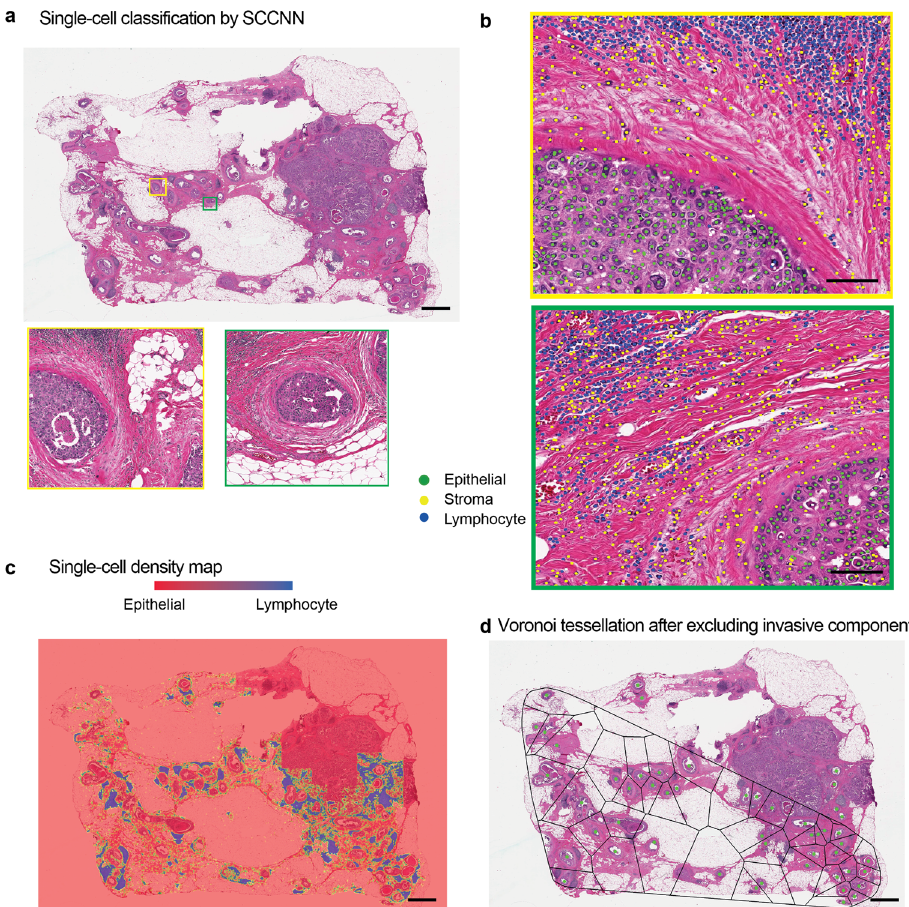
Fig. 5 UNMaSk results with single-cell classi fi cation and Voronoi tessellation. a A representative example of an adjacent DCIS case illustrating single-cell classi fi cation results in two DCIS regions. Scale bar represents 100 µm. b High-resolution images of areas within the two DCIS regions, showing single-cell classi fi cation using uni fi ed segmentation and classi fi cation pipeline based on DRDIN and SCCNN, classifying cells into the epithelial cell (green), stromal cell (yellow) and lymphocyte (blue). Scale bar represents 50 µm. c Heatmap showing lymphocyte cell density based on single-cell classi fi cation results. d Voronoi tessellation using the centres of DCIS ducts as seeds, performed over tissue region excluding epithelial cells identi fi ed by single-cell classi fi cation that was not DCIS. Because of the mathematical principles underlying Voronoi tessellations, lymphocytes within a polygon will be closer to its seed than any other seeds. This means that each lymphocyte can now be assigned to its closest DCIS duct within the tessellation space, thereby quantifying lymphocyte abundance for each DCIS duct locally. Note that because convex polygon was used, some of the DCIS ducts closer to the invasive region were omitted from the analysis. Scale bar represents 100